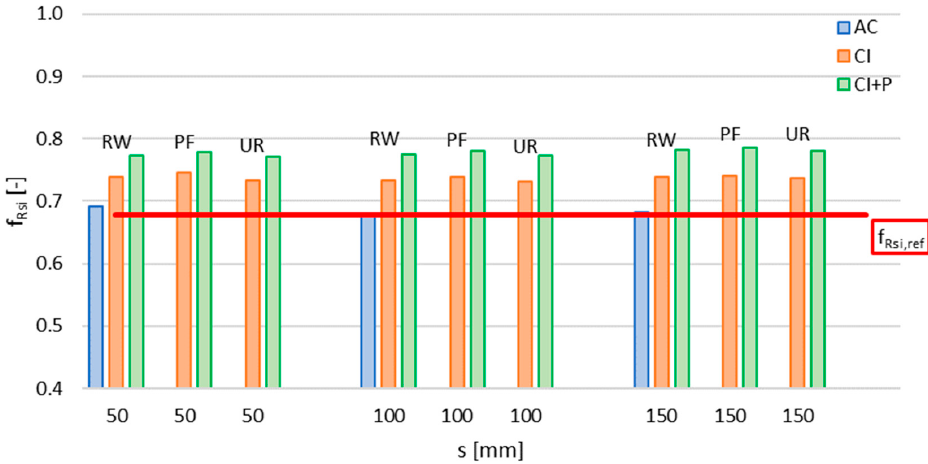
Figure 10. Temperature factor on the thermal bridge f Rsi with